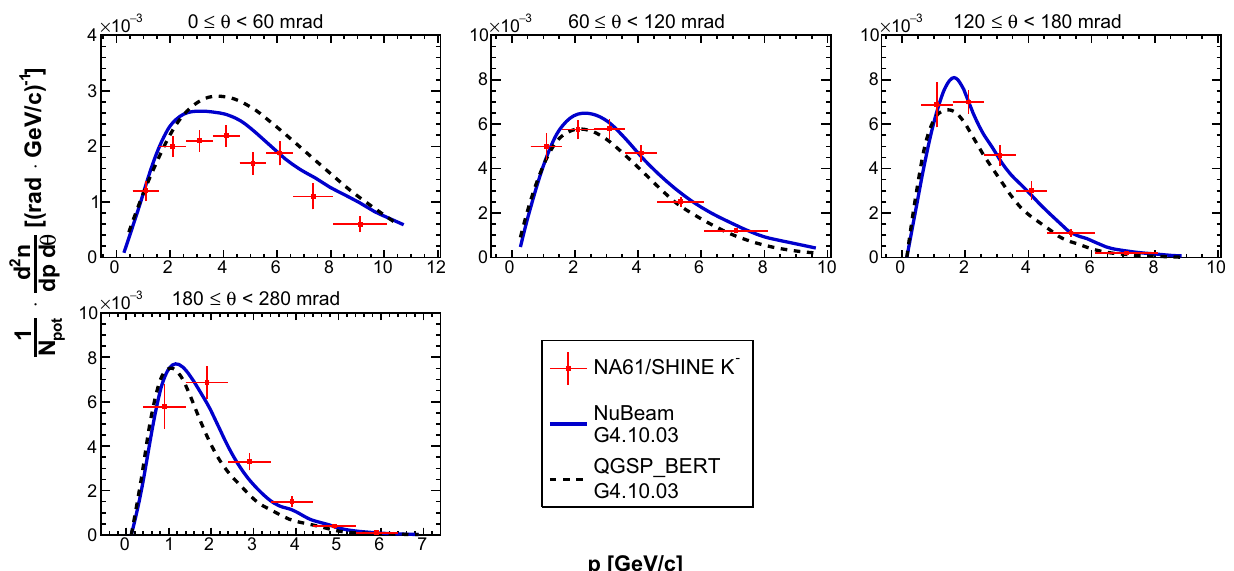
Fig. 45 Double differential yields of negatively charged kaons for the fifthupstreamlongitudinalbin(72 ≤ z < 90cm).Verticalbarsrepresent the total uncertanties. Predictions from the NuBeam (solid blue line)